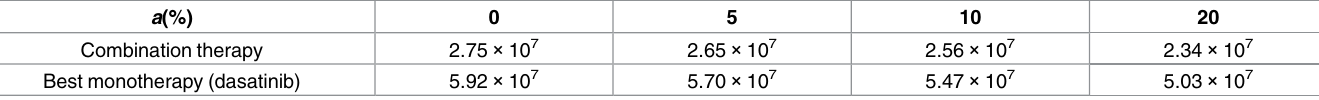
Table 9. The leukemic cell burden after a 36-month treatment for preexisting M351T assuming TKIs reduce the leukemic stem cell production rates. We assume that the TKIs reduce the productionrate of each leukemicstem cell by a %. a